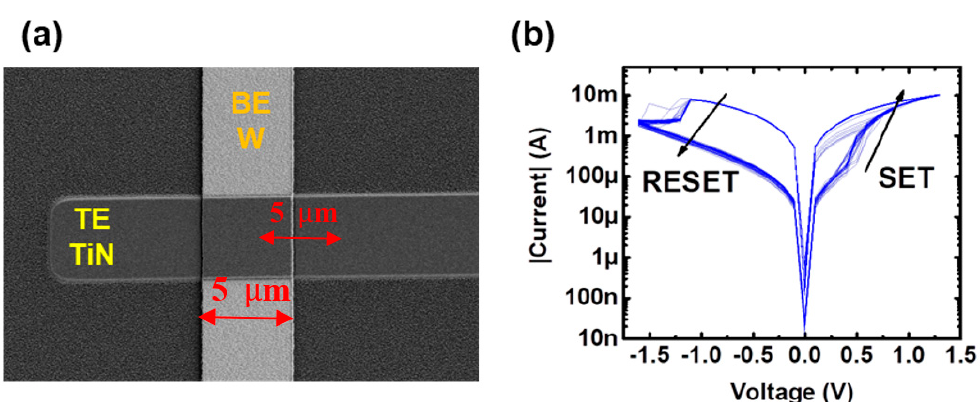
Figure 4. ( a ) SEM image of the tested structure ( b ) Experimental I-V characteristics of the analyzed devices [29]. A voltage limit for the RESET process was set to − 1.6V, whereas for the SET process, the conductivity-controlling parameter was the maximum current driving the device (current compliance, I c ) set by the user.